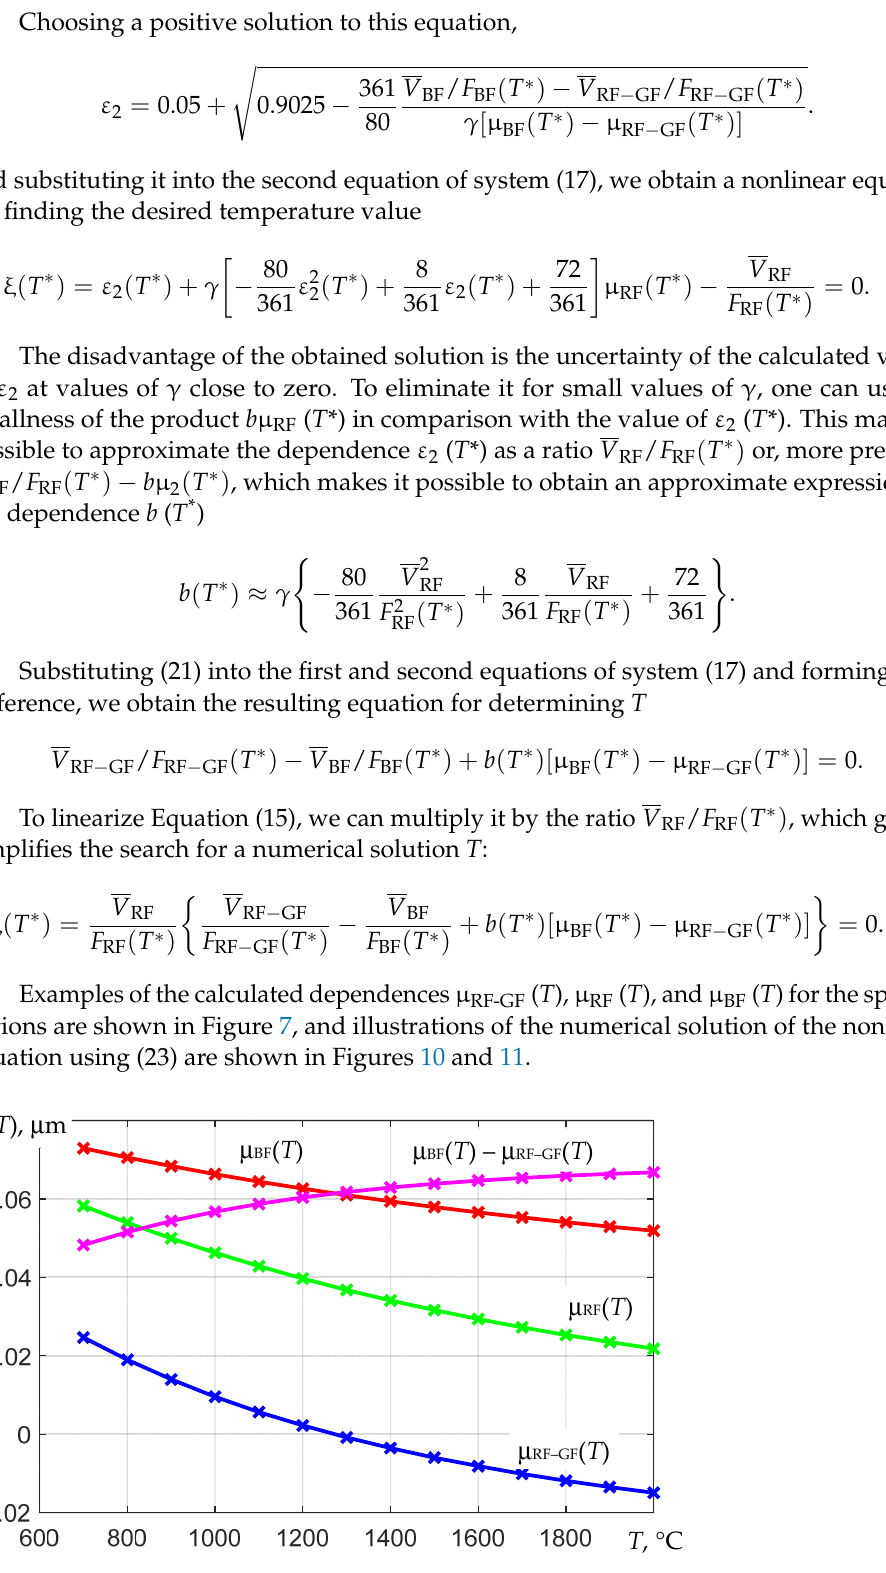
Figure 10. Calculated temperature dependences of the coefficients μ RF-GF ( T ), μ RF ( T ), μ BF ( T ), and μ BF ( T ) − μ RF-GF ( T ) for the spectral quantum efficiencies shown in Figure 7.